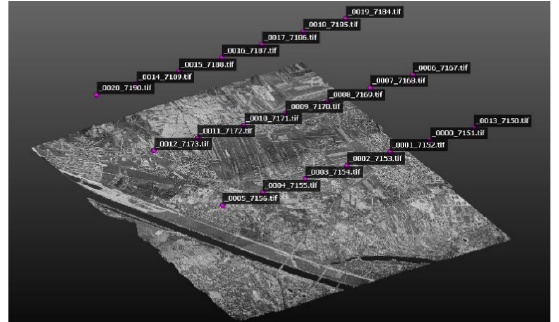
Figure 6. AT and DIM results for the 1976 aerial block (21 images) from the Vienna